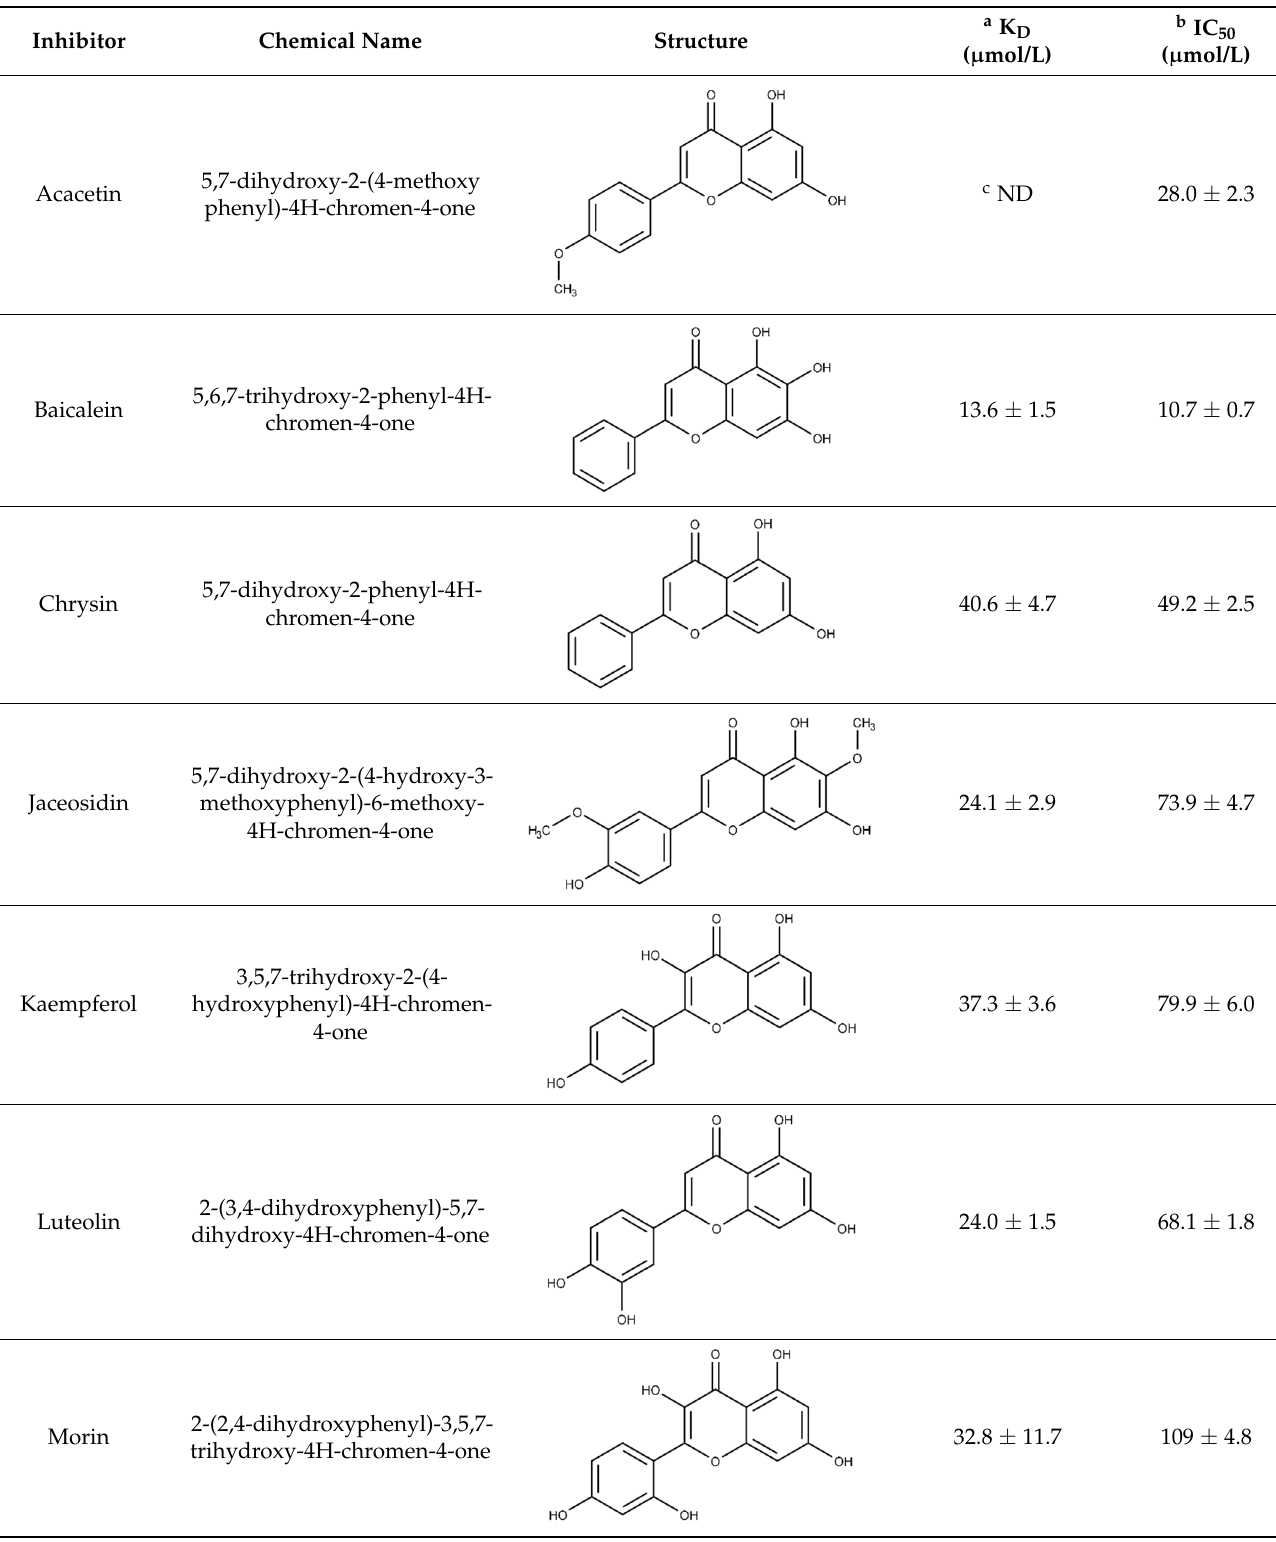
Table 1. Chemical Inhibitors of Table 1. Chemical Inhibitors of Plx2A. Table 1. Chemical Inhibitors of Plx2A. Table 1. Chemical Inhibitors of Plx2A. Table 1. Chemical Inhibitors of Plx2A. Table 1. Chemical Inhibitors of Plx2A. Table 1. Chemical Inhibitors of Plx2A. Table 1. Chemical Inhibitors of Plx2A.